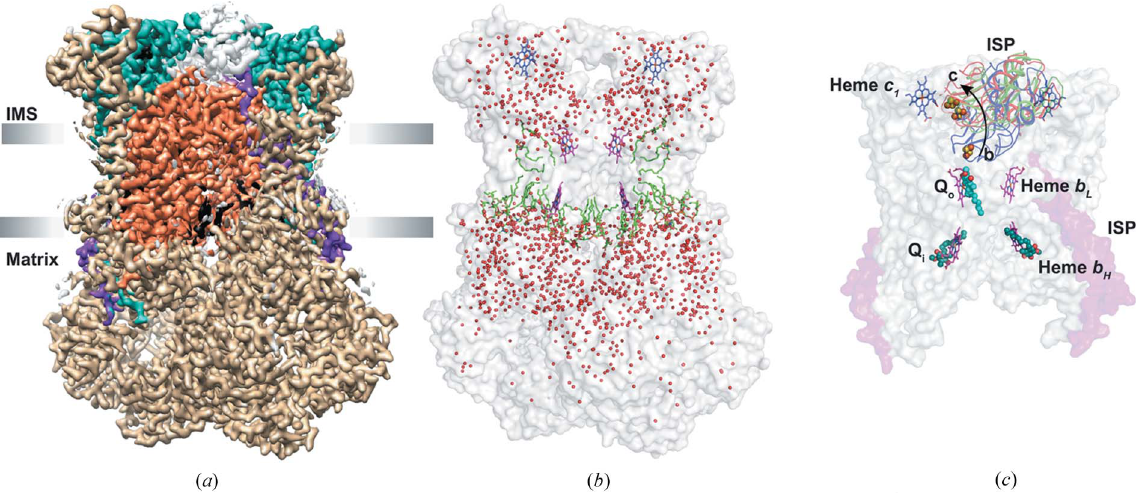
Figure 1 ( a ) CryoEM map of Yarrowia lipolytica complex III dimer. The consensus map (EMD-15312) of the complex at an overall resolution of 2 A˚ is shown. The map was calculated with deepEMhancer (Sanchez-Garcia et al. , 2021) from the two half-maps. The core subunits of complex III, cytochrome b , c 1 and ISP are coloured orange, green and purple, respectively. The supernumerary subunits are coloured in tan and the non-protein densities are in black. Unmodelled densities are shown in grey, in particular the blurred density of the ISP hydrophilic domain can be seen. ( b ) The surface representation of the consensus model (PDB entry 8ab6) of complex III is shown in white. The co-factors and lipid/detergent molecules are shown in stick representation (the carbon atoms in heme b L and heme b H in purple, high potential heme c 1 in blue, and lipid/detergent molecules in green). The water molecules are shown as red spheres. In the consensus model, only the transmembrane helix of the Rieske protein has been modelled and hence the 2Fe–2S cluster is not shown. ( c ) The surface representation of the core subunits of complex III with the TM helix of ISP coloured in purple. Typically observed positions of the hydrophilic domain of ISP are shown (from antimycin-treated samples) from b position to c position (blue, green and red for b, intermediate and c positions, respectively, are shown in cartoon representation). The 2Fe–2S cluster is shown as spheres and the movement of this cluster is shown with an arrow. The quinones in the Q i site (green) and the Q o site (cyan) are from different models (PDB entries 8abk and 8ab8, respectively) but shown in this figure to highlight the quinone binding sites. Figures were prepared with Chimera (Goddard et al. , 2007) and PyMOL (DeLano,